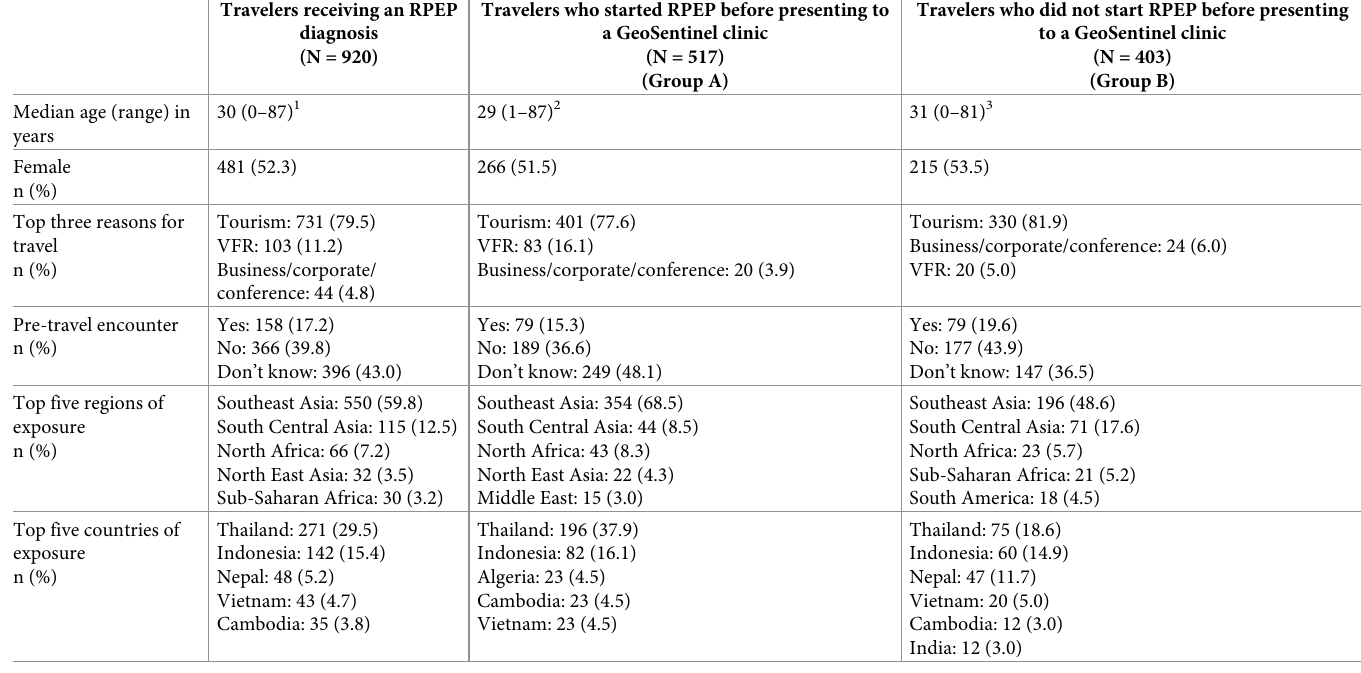
Table 2. Demographics, travel characteristics, and clinical presentation of travelers reported to GeoSentinel who received rabies post-exposure prophylaxis, Sep- tember 2014–July 2017 (N = 920). Travelers receiving an RPEP Travelers who started RPEP before presenting to Travelers who did not start RPEP before presenting diagnosis a GeoSentinel clinic to a GeoSentinel (N = 920)